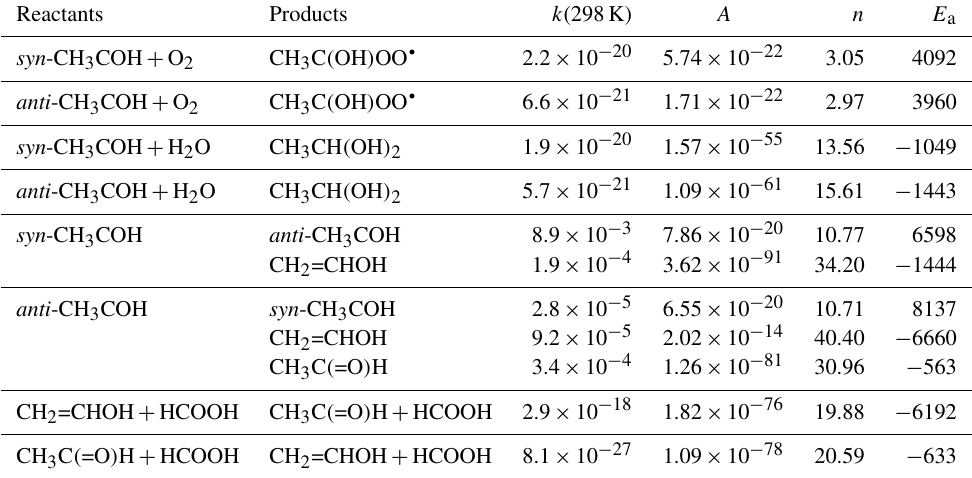
Table 2. Theory-predicted high-pressure rate coefficients for reaction of singlet CH 3 COH. Reactants Products k (298K )